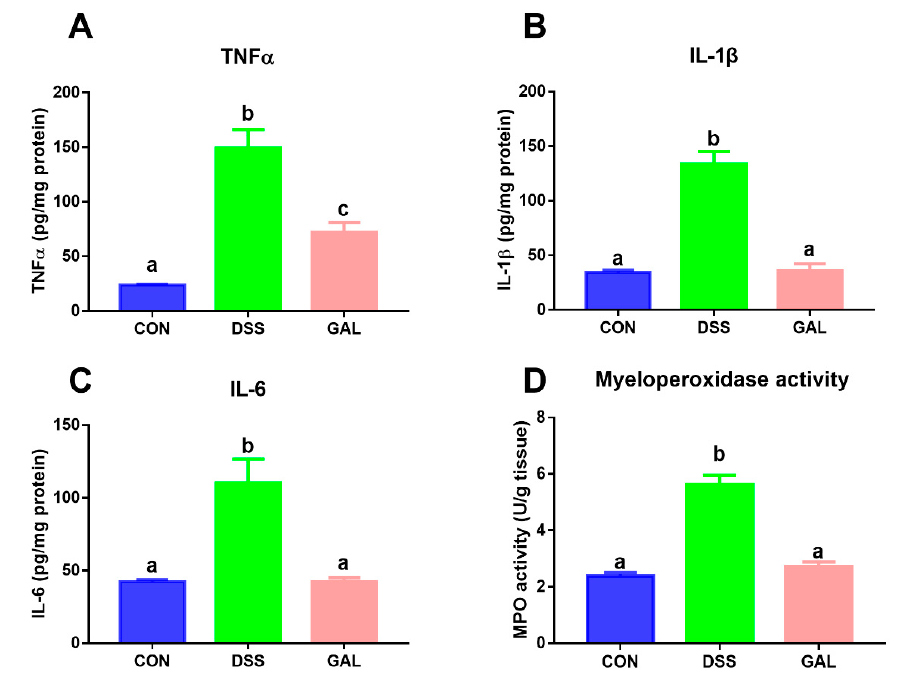
Figure 2. Effects of galangin administration on inflammatory mediators in the colons from DSS-induced colitic mice. ( A ) Tumor necrosis factor (TNF)- α , ( B ) interleukin (IL)-1 β , ( C ) IL-6, and ( D ) myeloperoxidase (MPO) levels in the colonic tissues. The values are expressed as mean ± SD ( n = 6). Means sharing the same letter are not significantly different from each other ( p < 0.05).